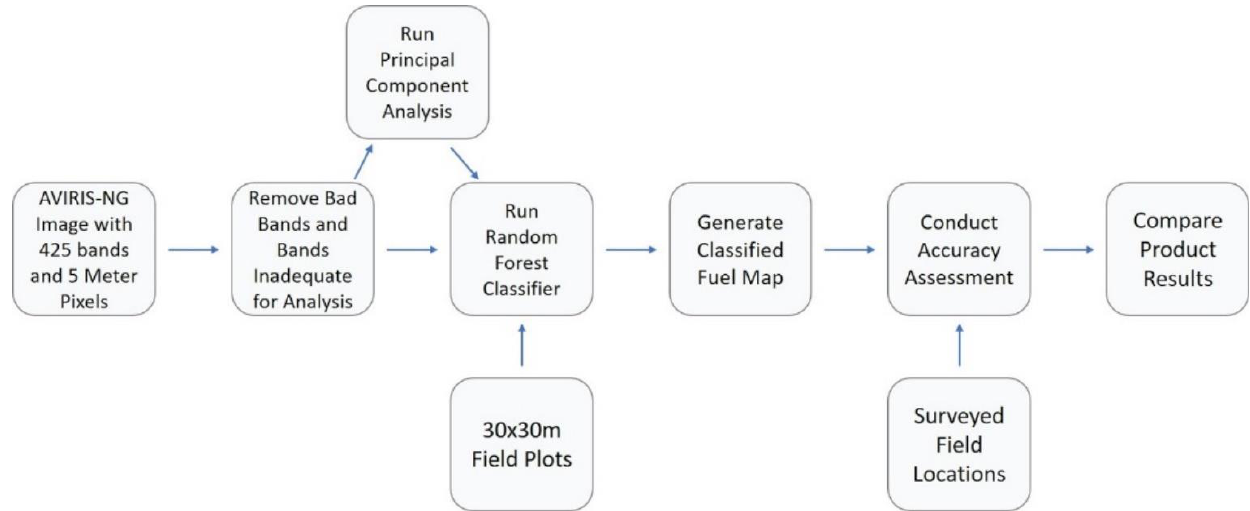
Figure 6 . Workflow for AVIRIS-NG image preprocessing and vegetation classification. Figure 6. Workflow for AVIRIS-NG image preprocessing and vegetation